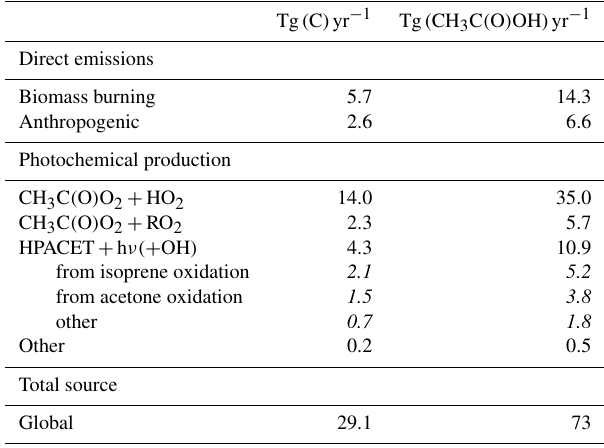
Table 6. Global sources of CH 3 C ( O ) OH in the model simulation. Roman font is used for the main sources, whereas subtotals are shown in italic